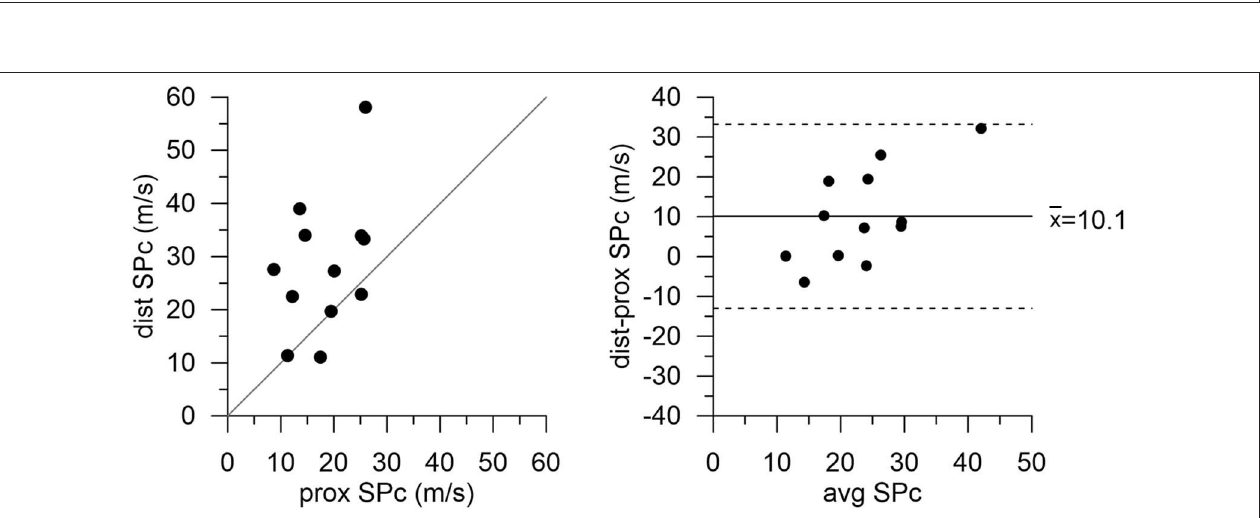
18.3 ± 1.8 m/s, p < 0.02). Despite the lower distending